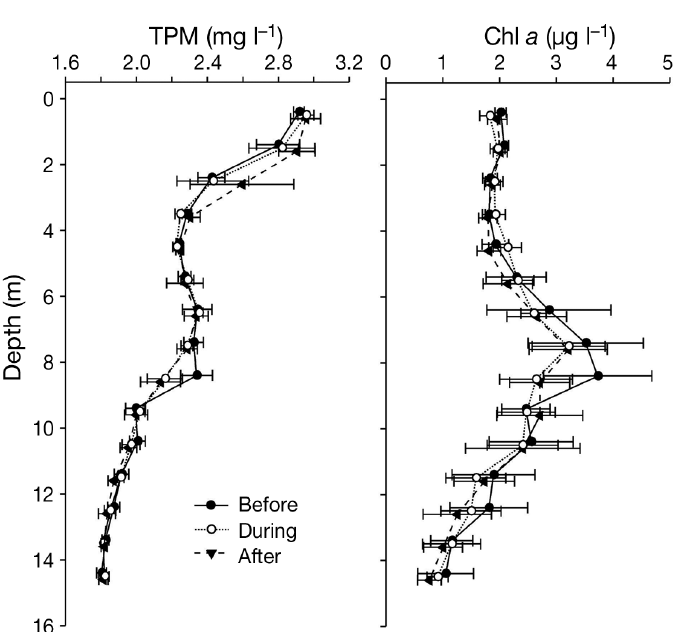
Fig. 4. Depth profile plots of total suspended particulate matter (TPM) and chlorophyll a (chl a ) concentrations measured on 28 July 2011 inside the Kyuquot Sound sablefish net-pen before, during and after manual feeding of fish. Average (±1 SD)